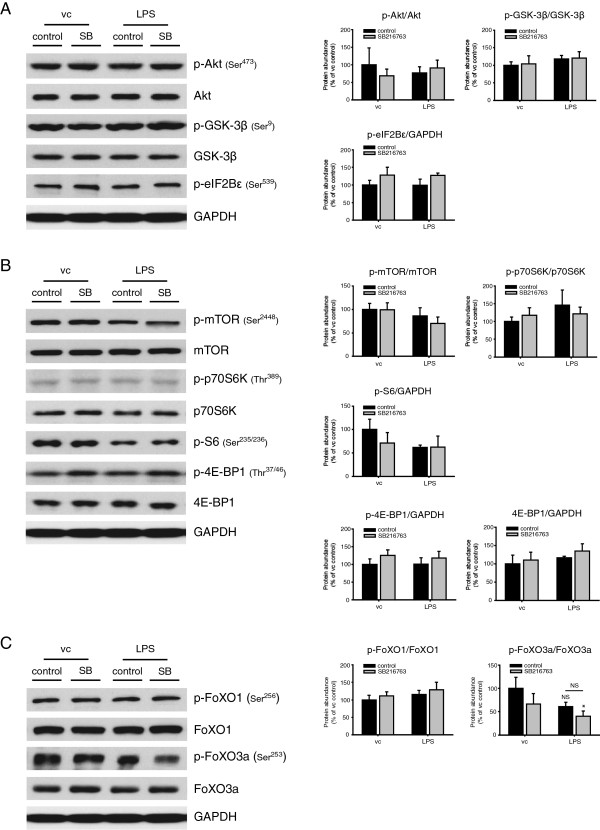
Muscle protein turnover signaling is not affected following chronic LPS-treatment and GSK-3 inhibition. Protein synthesis and protein degradation-related signaling molecules were determined in whole muscle homogenates of the extensor digitorum longus (EDL) muscles by Western blot analysis of guinea pigs that were treated intranasally with LPS or SB216763 for 12 weeks. Representative immunoblots depict protein levels of (A) phospho-Akt (p-Akt), total Akt, phospho-GSK-3β (p-GSK-3β), total GSK-3β, phospho-eukaryotic initiation factor 2Bϵ (p-eIF2Bϵ), GAPDH, (B) phospho-mammalian target of rapamycin (p-mTOR), total mTOR, phospho-p70S6K (p-p70S6K), total p70S6K, phospho-S6 (p-S6), phospho-4E-BP1 (p-4E-BP1), total 4E-BP1, GAPDH, (C) phospho-FoXO1 (p-FoXO1), total FoXO1, phospho-FoXO3a (p-FoXO3a), total FoXO3a and GAPDH. The accompanying bar graphs show the densitometric analysis results (means ± SEM, n = 6), represented as a percentage of the vc control group corrected for GAPDH. All data is shown as a ratio of phospho- to total protein for each target (except p-eIF2Bϵ, p-S6 and (p-) 4E-BP1). *p < 0.05 compared with the vc control group. NS: not significant.